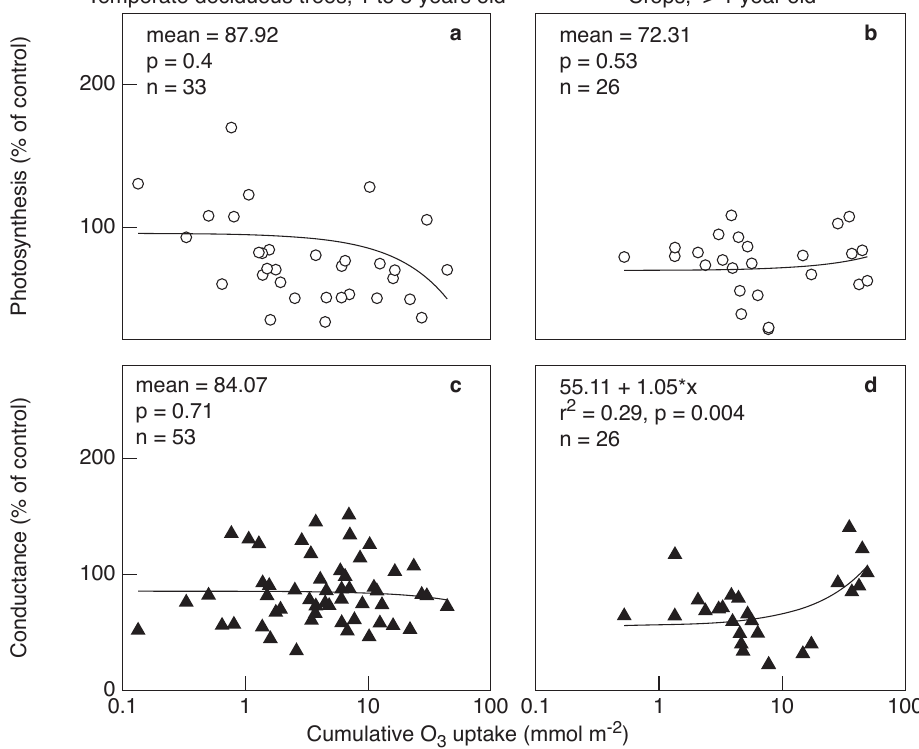
Fig. 8. The correlation of photosynthesis (open symbols; a–b ) and conductance (closed symbols; c–d ) to CUO for all temperate deciduous trees between one and five years old (a, c) and crops less than one year old (b, d) to chronic O 3 exposure for all plants grown in pots, exposed to 100–125ppbO 3 in growth chambers, and are compared to control plants exposed to charcoal-filtered air with medium or high confidence in cumulative O 3 uptake (CUO) calculations. Response values are reported as % of control (treatment/control). CUO is shown on a log scale, but linear analyses ( r 2 and line equations) were performed on non-log transformed data. r 2 values are only included for significant correlations, and n values are the number of data points included in the